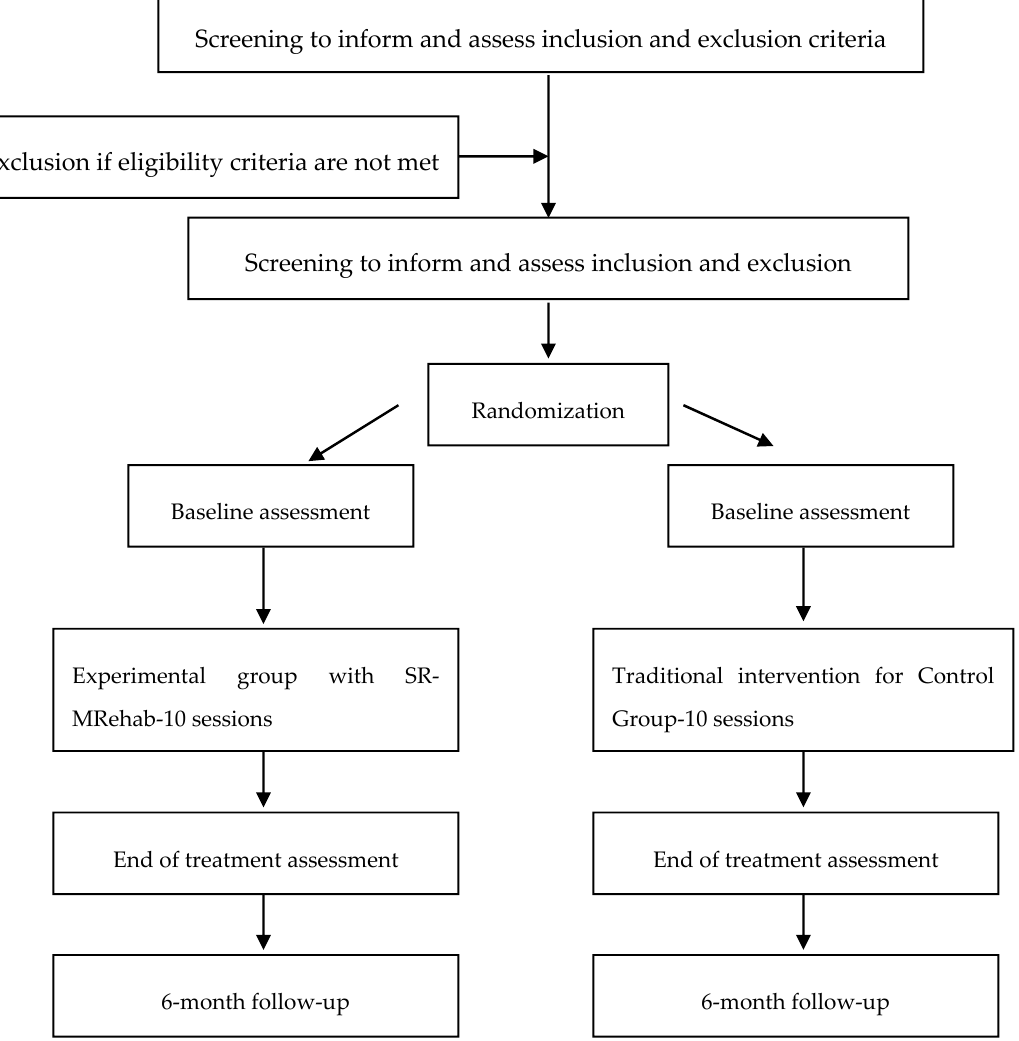
Figure 1. Recruitment and study procedure.